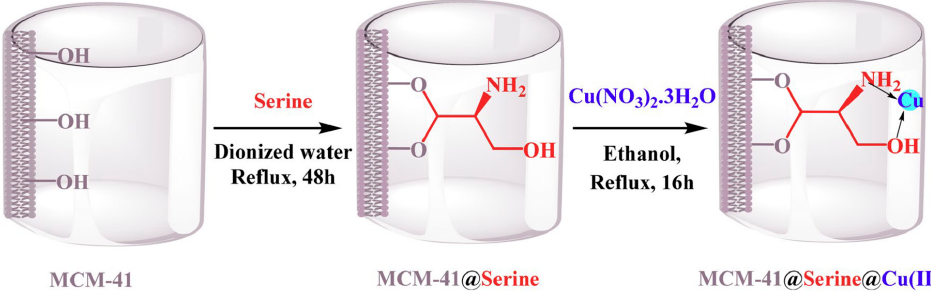
Figure 23. Synthesis of MCM-41@Serine@Cu(II). Reproduced with permission from [31]. Copyright 2018